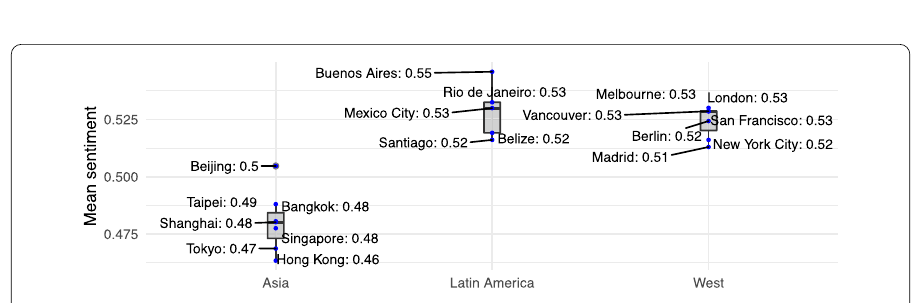
Figure 9 Mean value of Sentiment Analysis